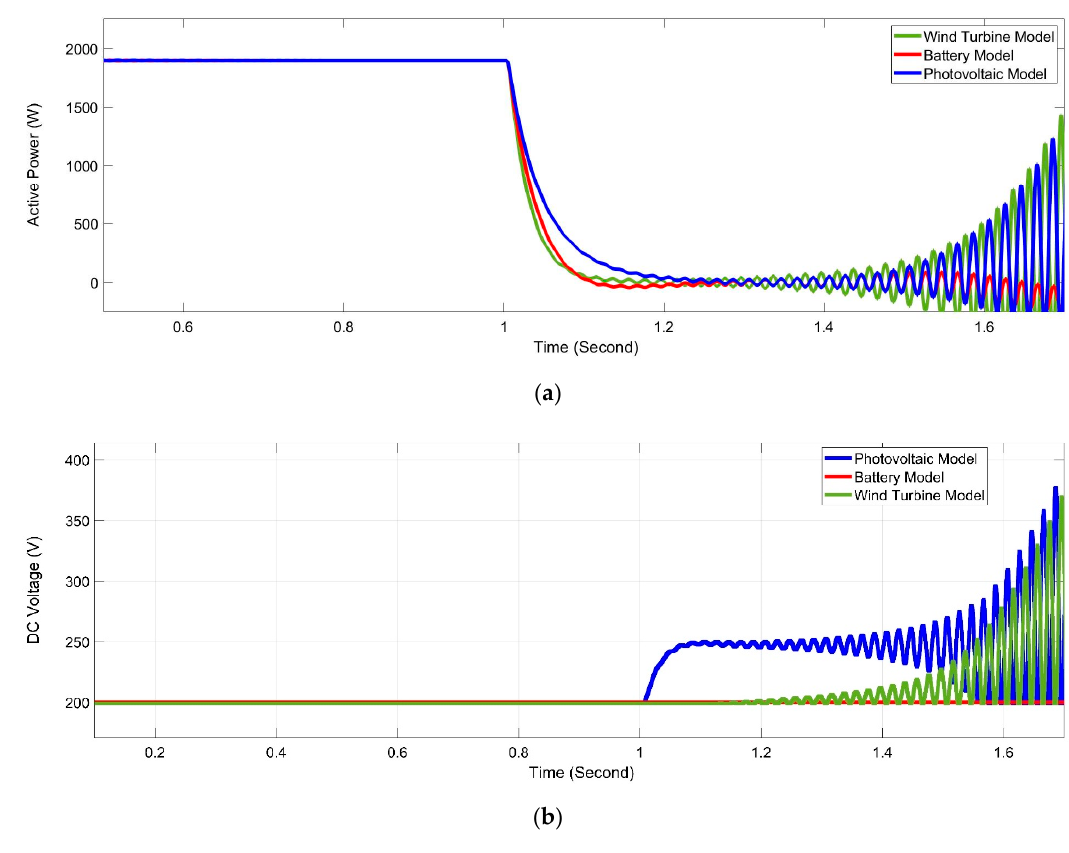
Figure 20. Simulation result, where ( a ) the averaged power response, ( b ) response of DC link volt- age.